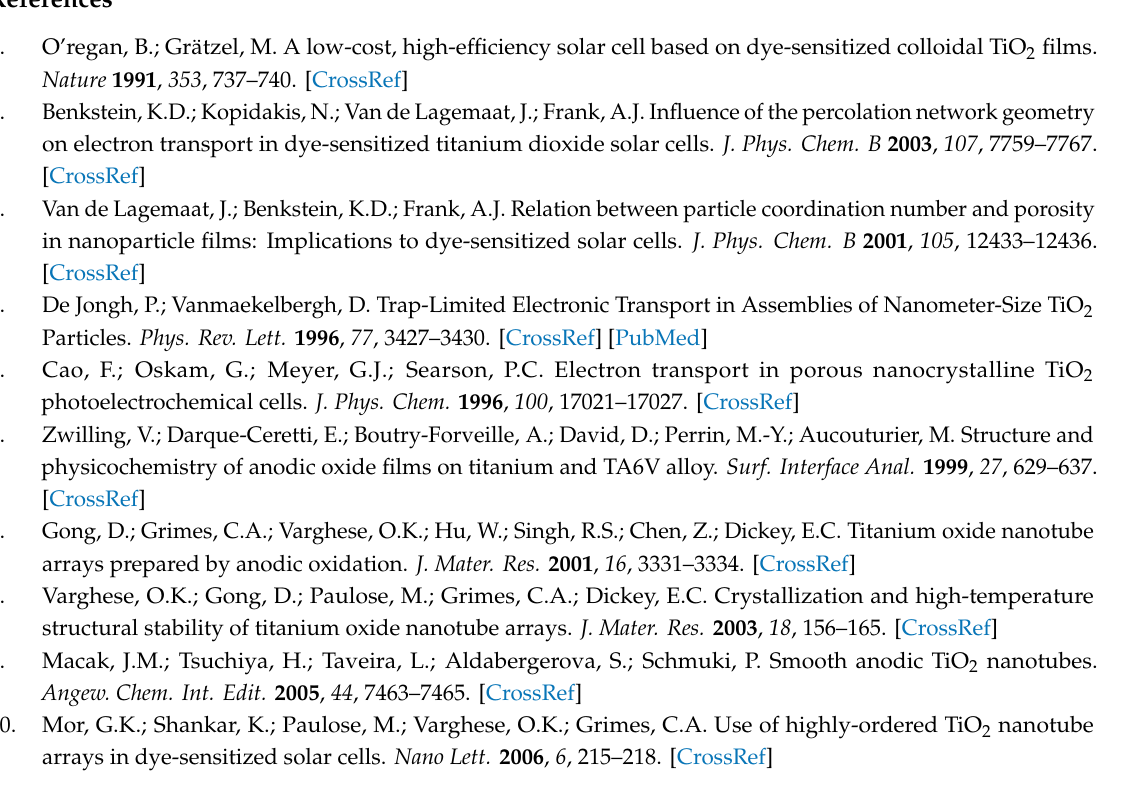
Figure S1. External quantum e ffi ciency (EQE) of DSSC. The black line is the DSSC based on the TNTAs and the red line is the DSSC based on the TNTAs with Au NP and carbon materials; Figure S2. Energy band diagram of DSSC based on the